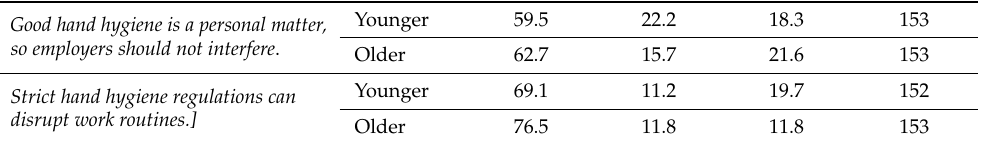
Table 10. Statements negatively correlated with age of respondent. Spearman rank correlation, p < 0.01. (Older ⇒ > median, Younger ⇒ <